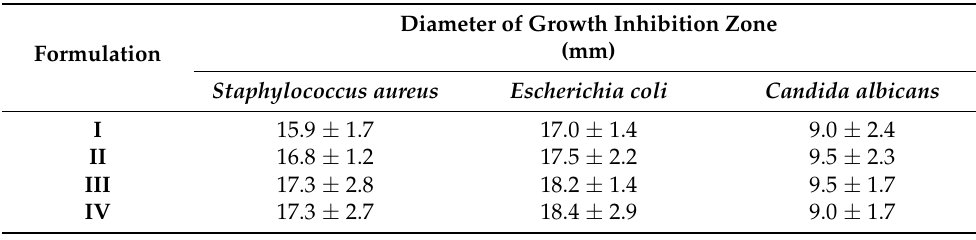
Table 4. Diameter of microbial growth inhibition zone (mm) by using the four different formulations. Experimental data are reported as mean ± SD ( n =